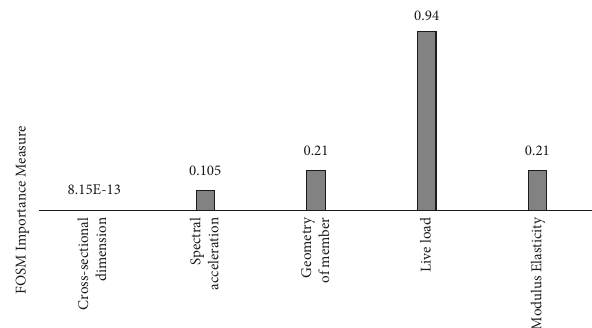
Figure 12: Scale diagram of the significance of type III frame uncertainties in the FOSM method.